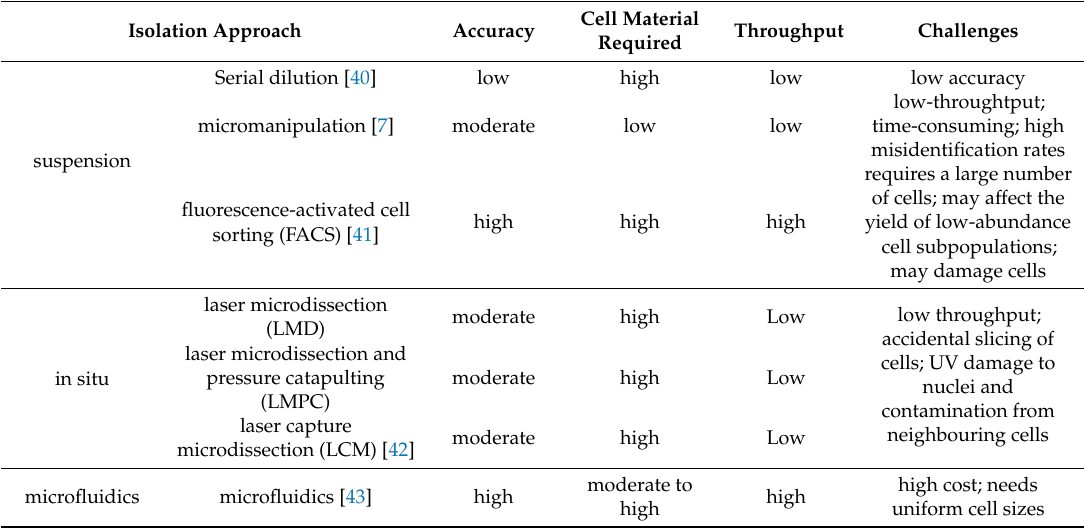
Table 1. Comparison of selected single-cell isolation approaches.